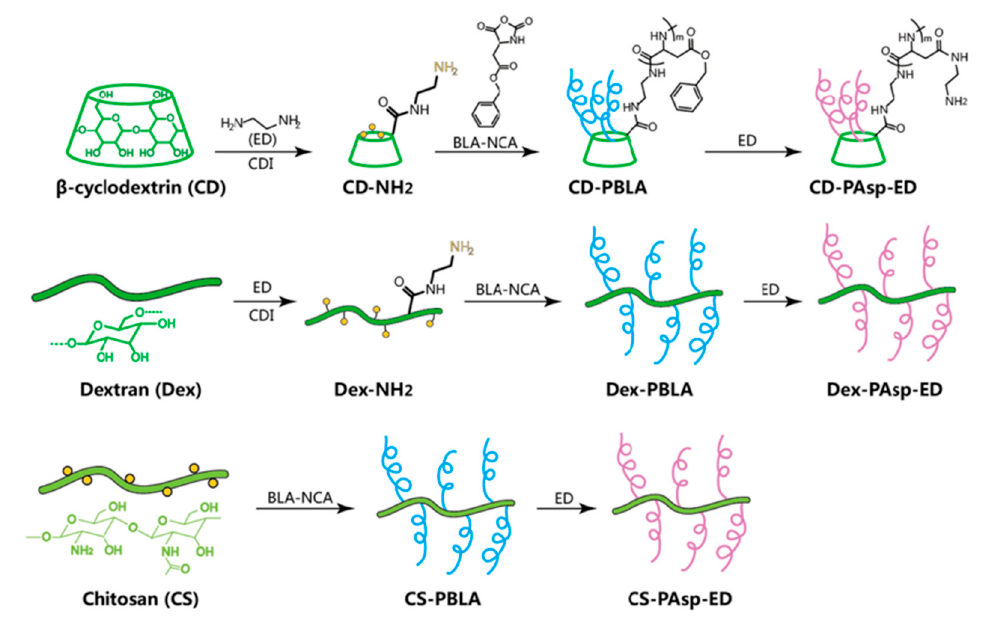
Figure 3. Illustration of the preparation processes of several graftable polysaccharides. Modified from [70].